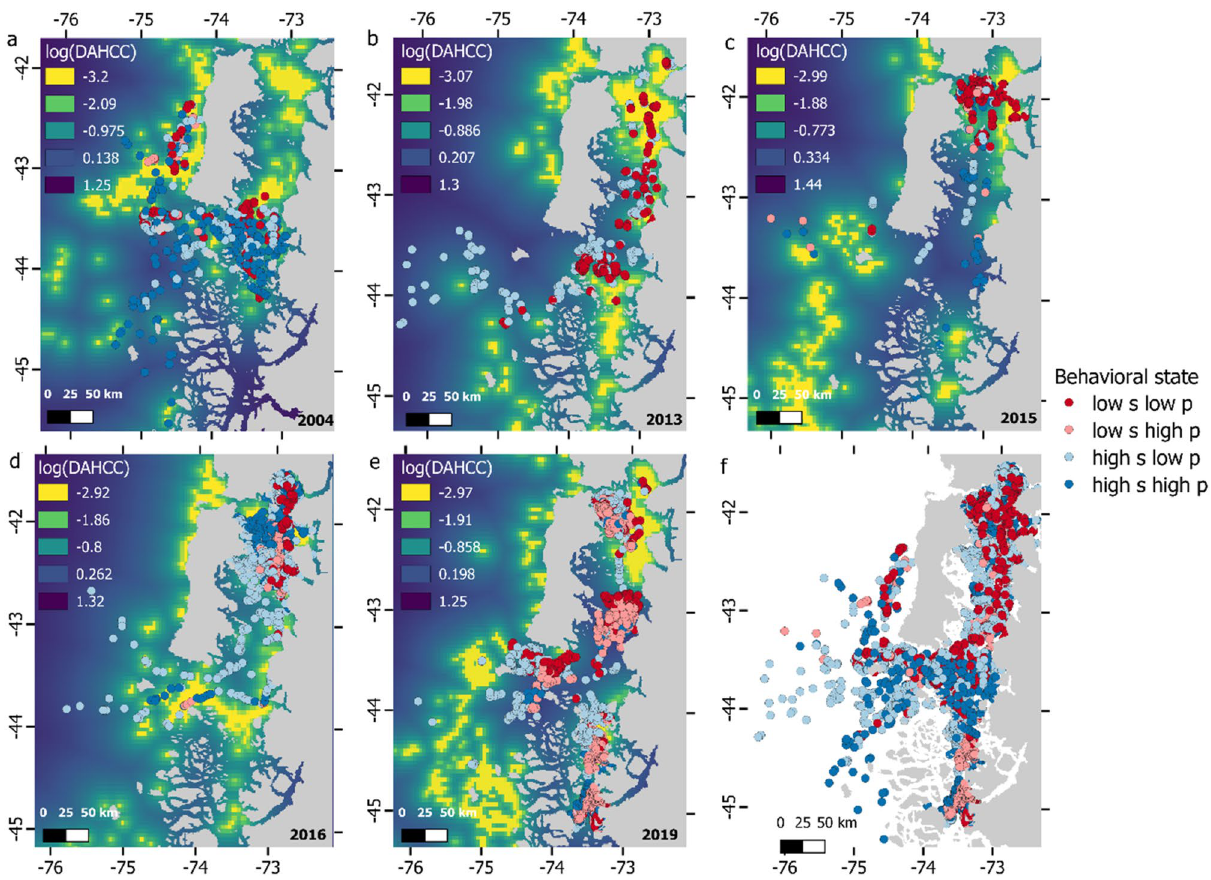
Figure 2. Behavioral variation for tagged whales. Panels ( a – e ) summarize results for 2004, 2013, 2015, 2016 and 2019, respectively and panel f combines all tracks. Red to blue four-color ramp indicates the percentile to which each location belongs regarding variation in σ t and 3/β t (persistence). By using the medians, the four possible combinations are presented as a posteriori behavioral state identification. Locations jointly holding values of σ t and 3/β t below their medians across all whales (low s and low p) can be considered ARS behavior, while the opposite (high s and high p) can be considered transit. Blue (far) to yellow (close) color ramp in the background indicates variation in standardized distance to areas of high chlorophyll concentration (DAHCC) in log scale, which was the most consistent covariate shaping blue whale movement patterns in this study. Data layers (including maps) were created in R ver. 4.0.2 (www.r-proje ct.org) and ensembled in QGIS ver. 3.8.0 (www.qgis. org) for final rendering. Maps were created using data on bedrock topography from the National Centers